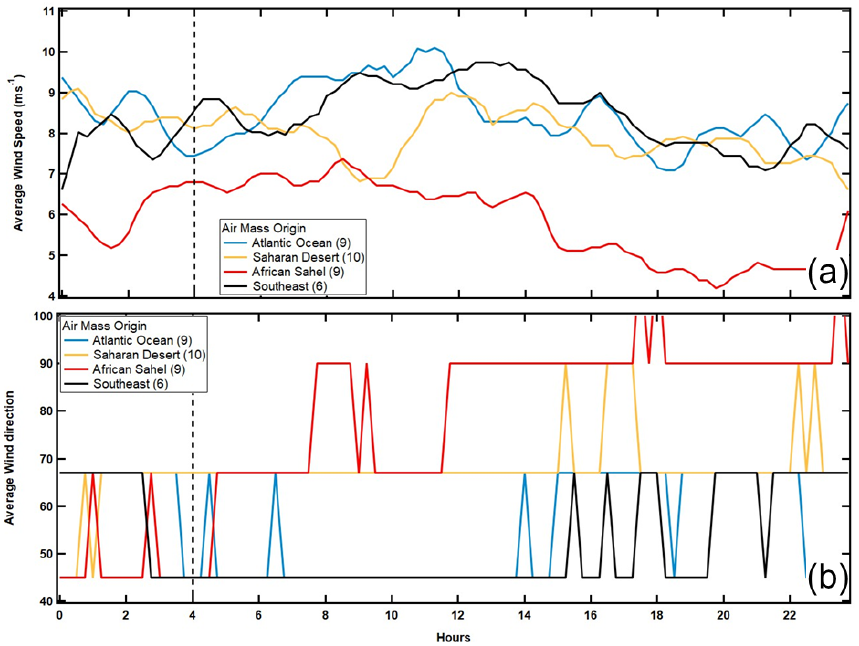
Figure 8. The average (a) wind speed and (b) wind direction during the time period of air mass intrusions are summarized in these figures for the air mass